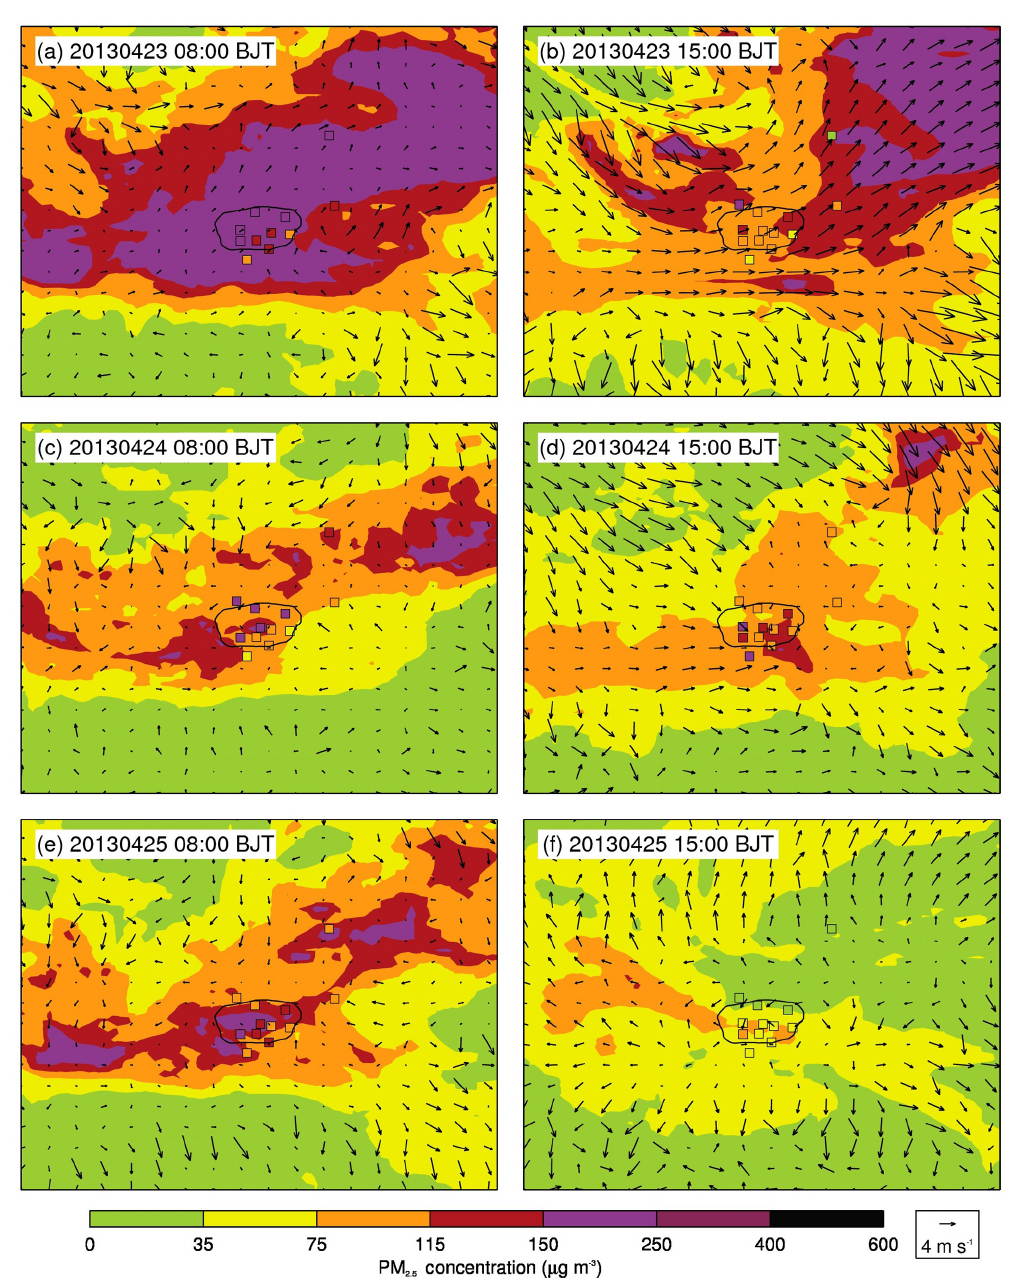
Figure 6. Spatial patterns of calculated (contours) and observed (squares) PM 2 . 5 concentrations at 08:00 and 15:00BJT from 23 to 25 April 2013 along with wind fields (back